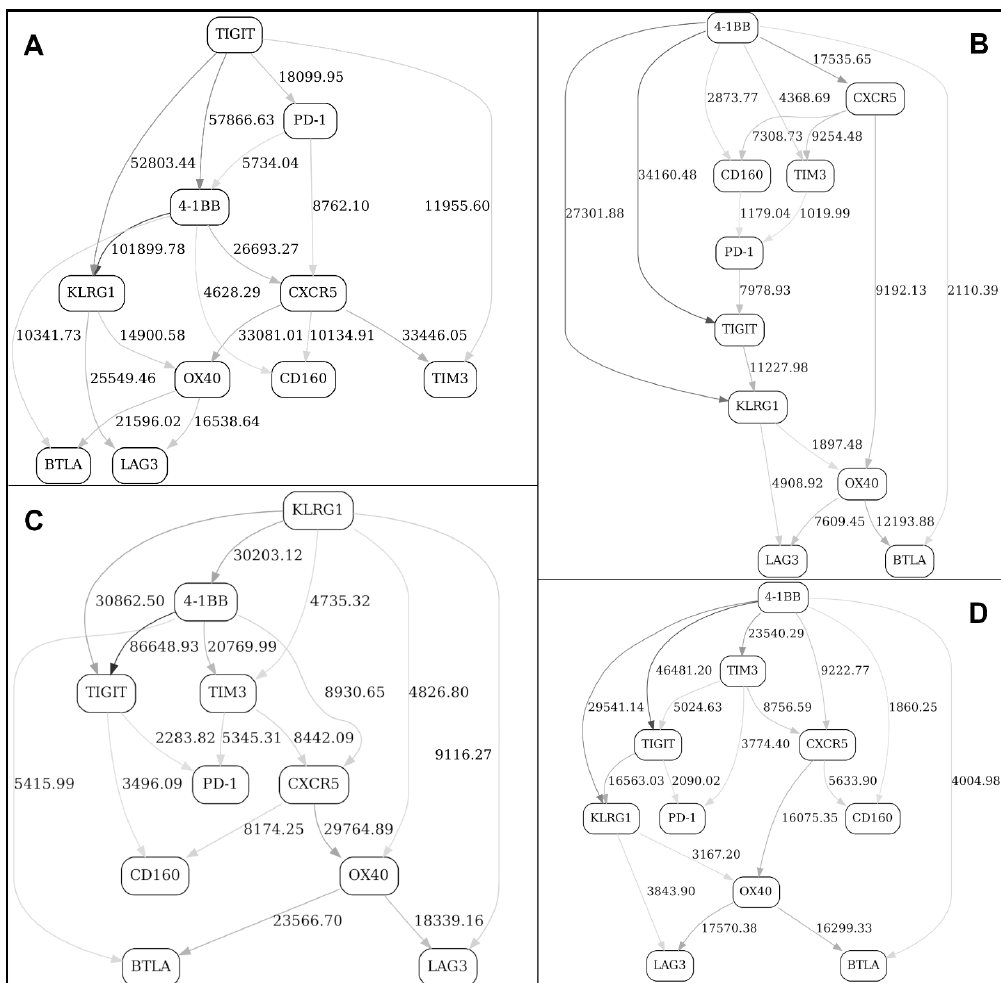
Figure 4. BNs constructed from FACS data (Checkpoint panel, Non-naïve CD4+ T cells subdataset) from 13 patients. ( A ) day 1, nonresponders only, ( B ) day 1, responders, ( C ) day 21, nonresponders, ( D ) day 21, responders. See Figure 1 legend for further details.